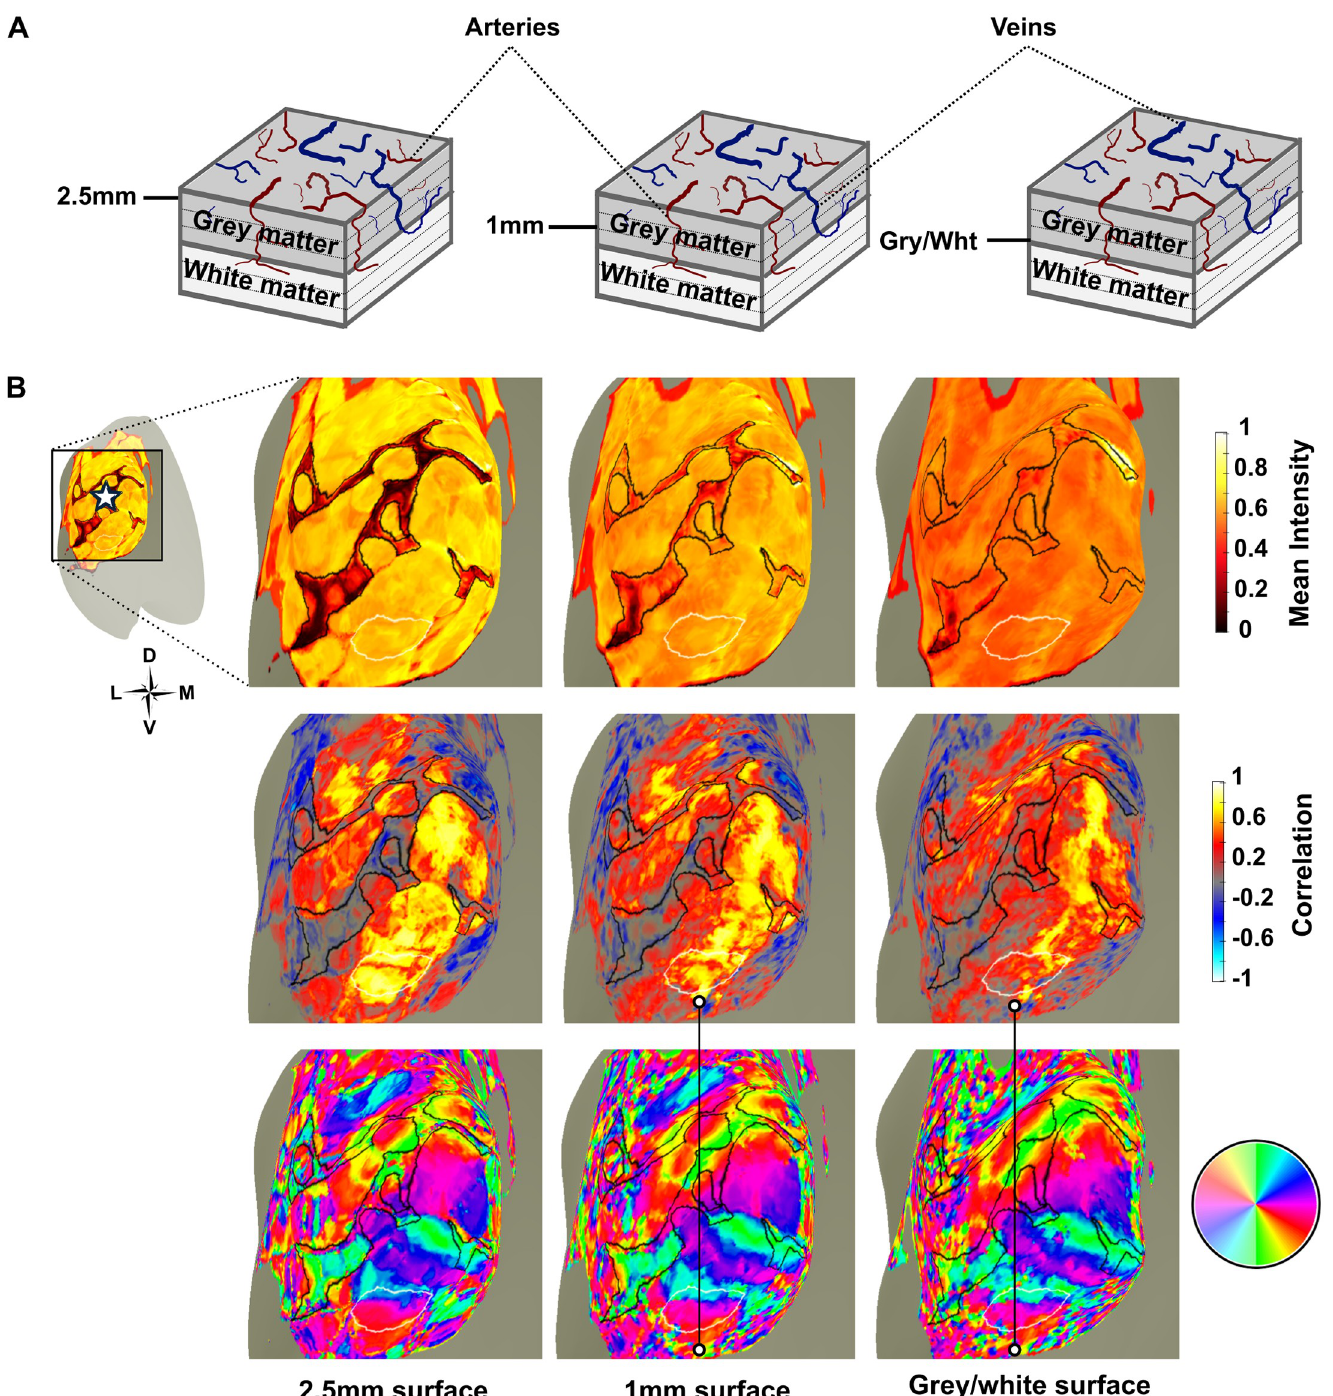
Fig 14. Depth-dependent effects of the venous eclipse in the left hemisphere of Subject 6. A) Schematic of layers of the cerebral cortex depicting cortical arteries (red) and veins (blue). These dive through the grey matter prior to turning at 90˚ at the white matter and thinning into branches [50]. B) Depth-dependent surfaces at 2.5mm, 1mm and the grey/white boundary showing the venous eclipse (outlined in black) and hV4 (outlined in white). The star in the top left insert represents the occipital pole. Mean intensity maps (top row) show the venous eclipse weakening with depth; a corresponding reduction in the number of inverted voxels within the venous eclipse is evident in the correlation maps (middle row). Polar angle maps (bottom row) show an incomplete map of hV4, which does not change across depth (note the ‘speckles’ indicated by the white dots in the second and third columns highlight what could be the lower vertical meridian of the hV4 map however, as the correlation map shows multiple inverted voxels in this region, it is difficult to trust the responses of these voxels).